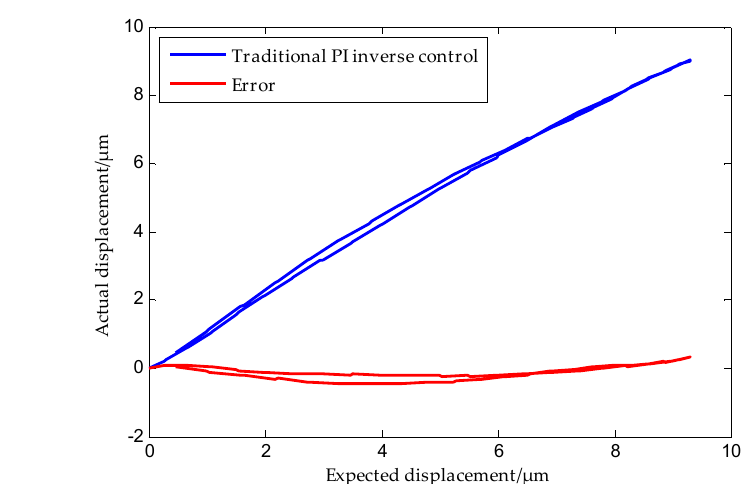
Figure 18. Block diagram of PI inverse model.